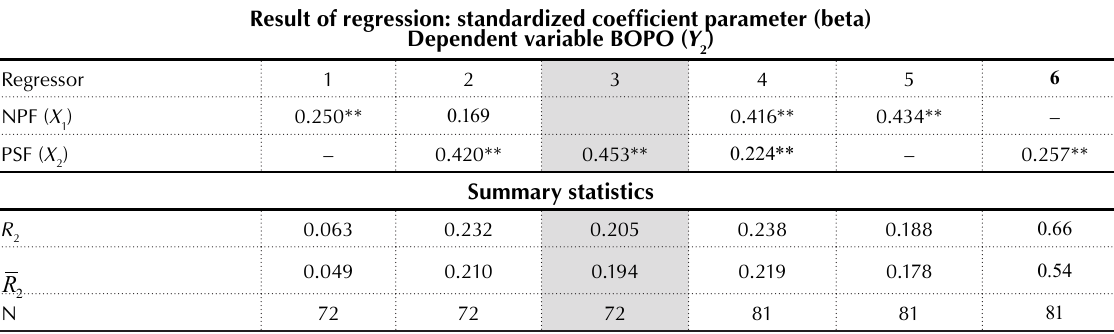
Table 3. The structural path for equation 1 (BOPO) Result of regression: standardized coefficient parameter (beta) Dependent variable BOPO ( Y ) 2